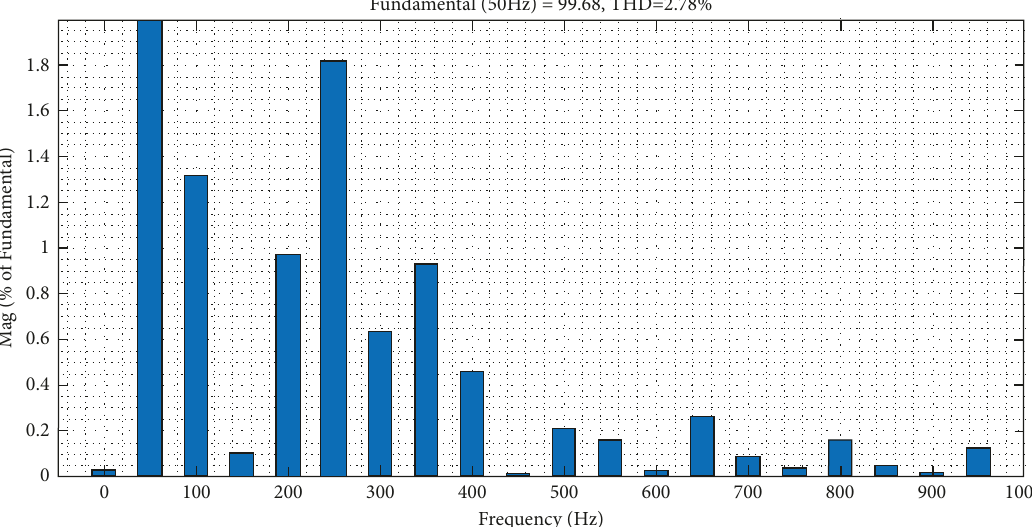
Figure 19: THD (current) for ANFIS with level shift